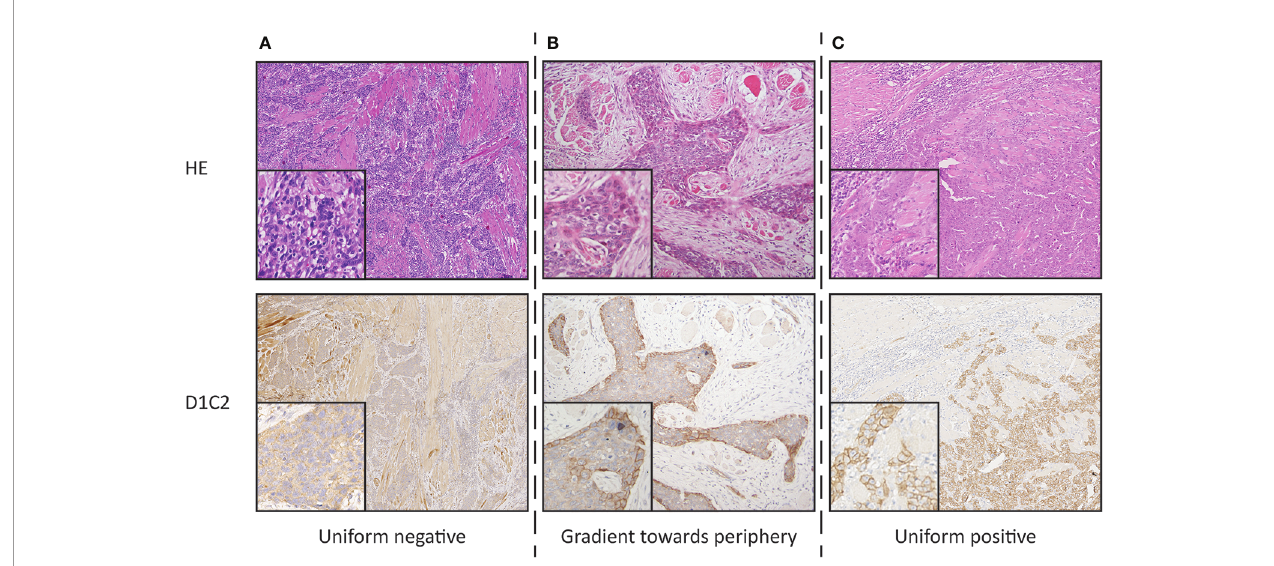
FIGURE 1 | Photographs representing the de fi ned staining patterns observed using D1C2 and corresponding HE section (10× and 20× objective). (A) Uniform negative (B) Gradient toward periphery. (C) Uniform positive. The gradient toward center staining pattern was not